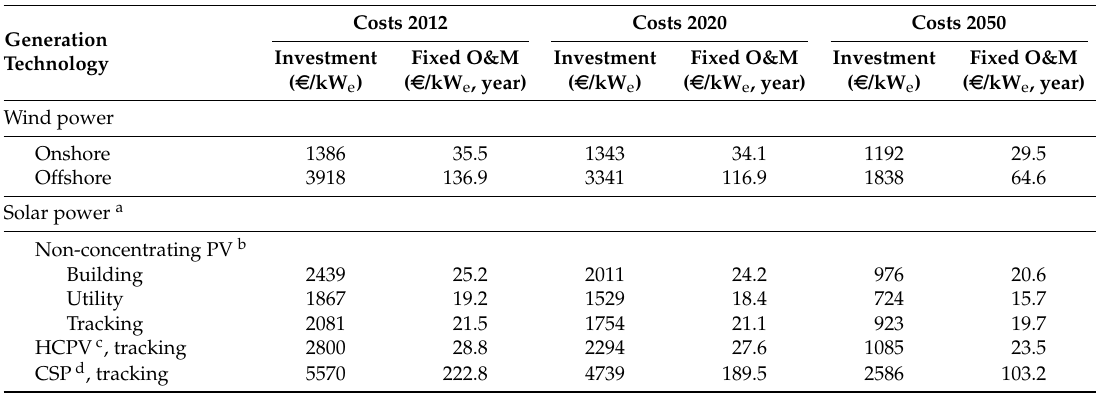
Table A3. Base input data and assumptions for variable renewable electricity generation technologies available for investment in the ELIN model. Investment costs come from [22], and the cost curves used in the model are fitted from these data. Technical lifetimes are assumed to be 25 years for all variable renewable technologies (based on the assumptions in [30]).